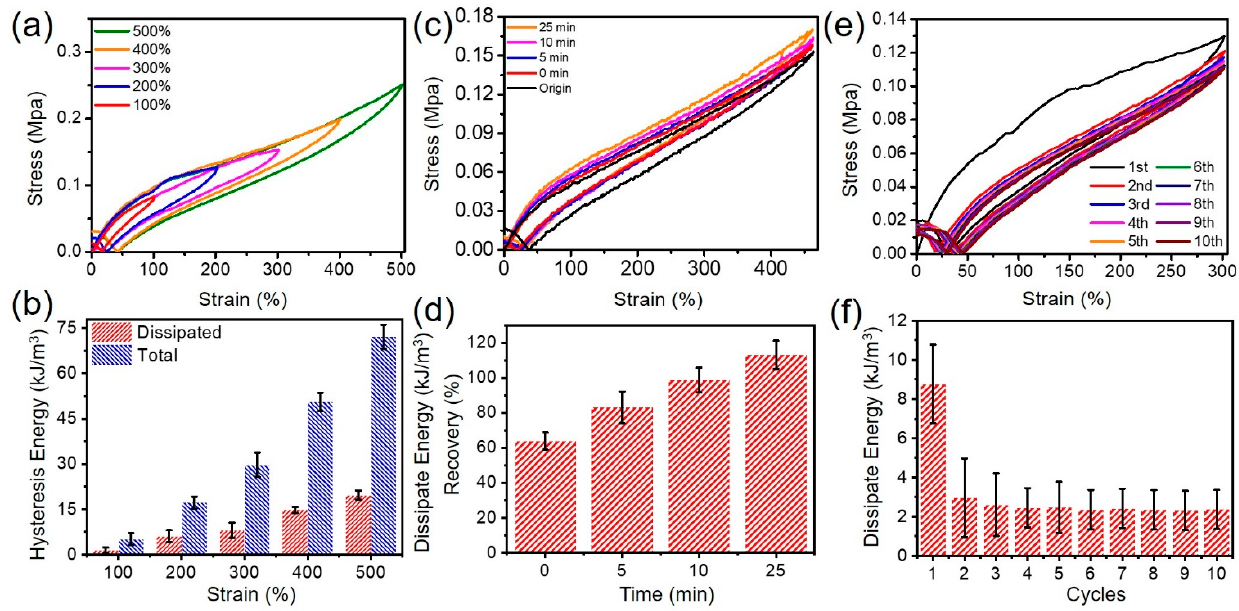
Figure 3. Hysteresis and self-recovery properties of CMCS-Ca 2+ /PAAm/PNMA hydrogels. ( a ) Representative stretching- relaxation tensile measurement with a series of strains (100%, 200%, 300%, 400% and 500%) and ( b ) the corresponding hysteresis energy and dissipated energy. ( c ) Cyclic tensile measurement with different rest intervals (0% to 400% strain with origin, 0 min, 5 min, 10 min and 25 min rest intervals); ( d ) the corresponding recovery ratio; ( e ) 10 stretching–relaxation cycles and ( f ) the corresponding dissipated energy.